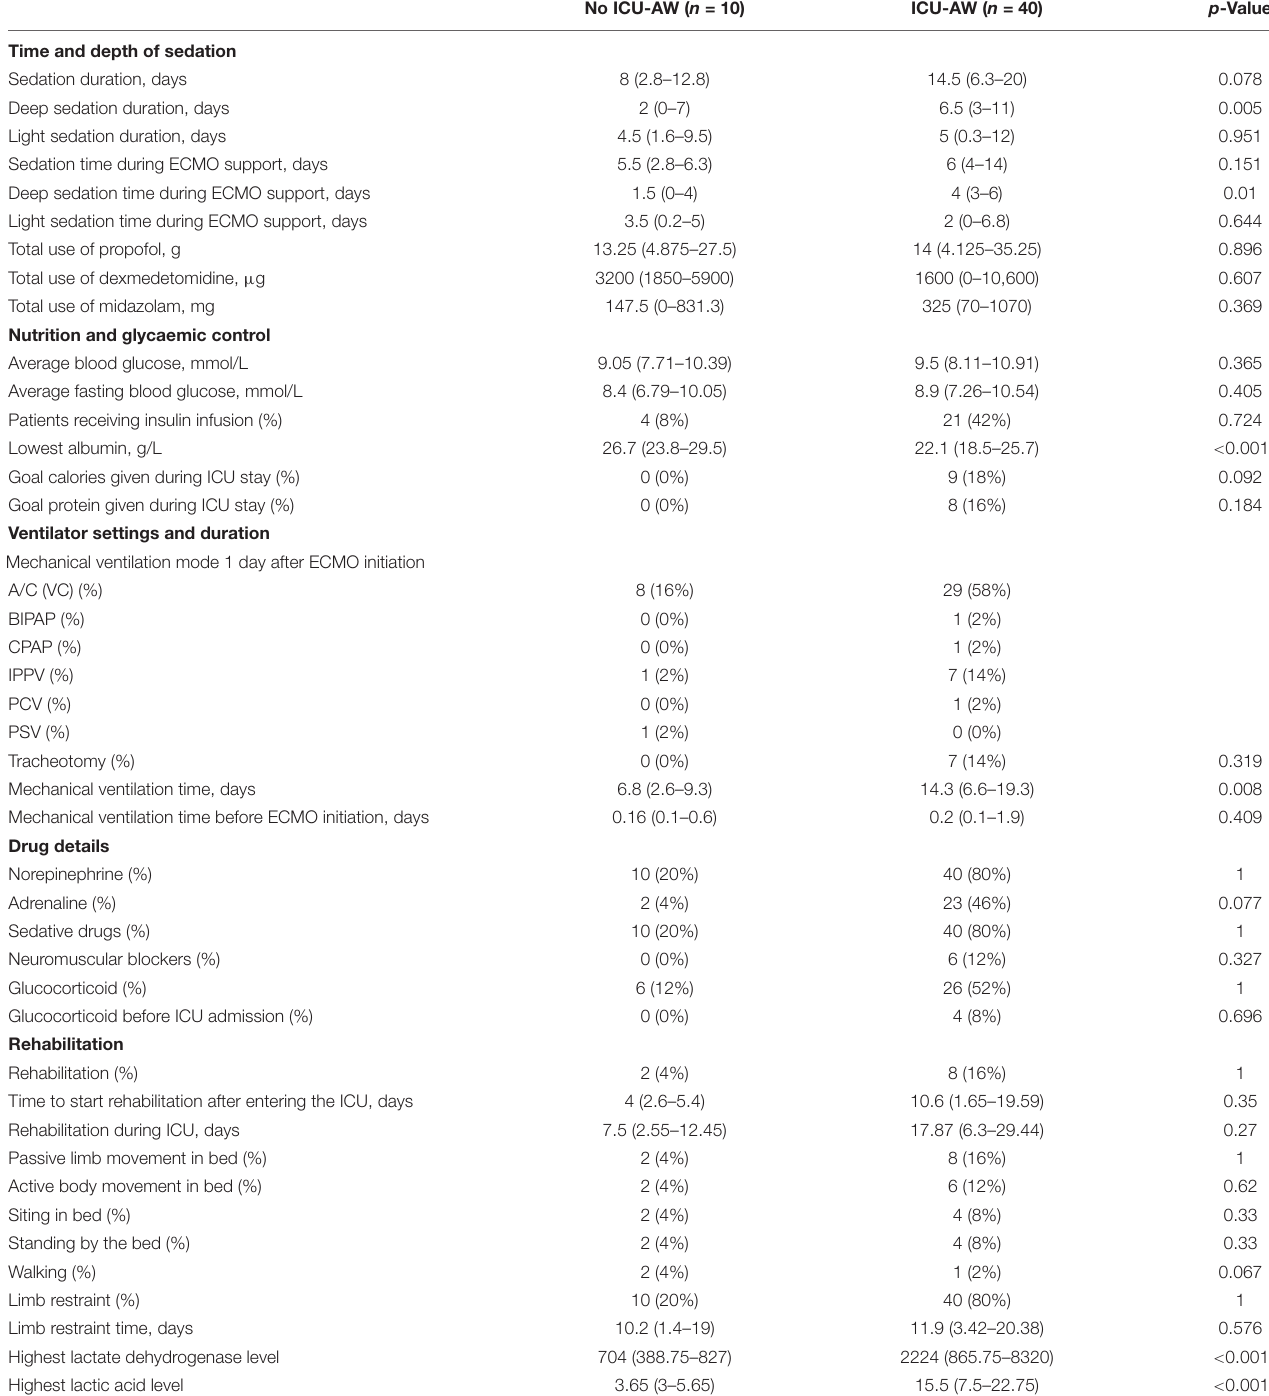
TABLE 2 | Therapy